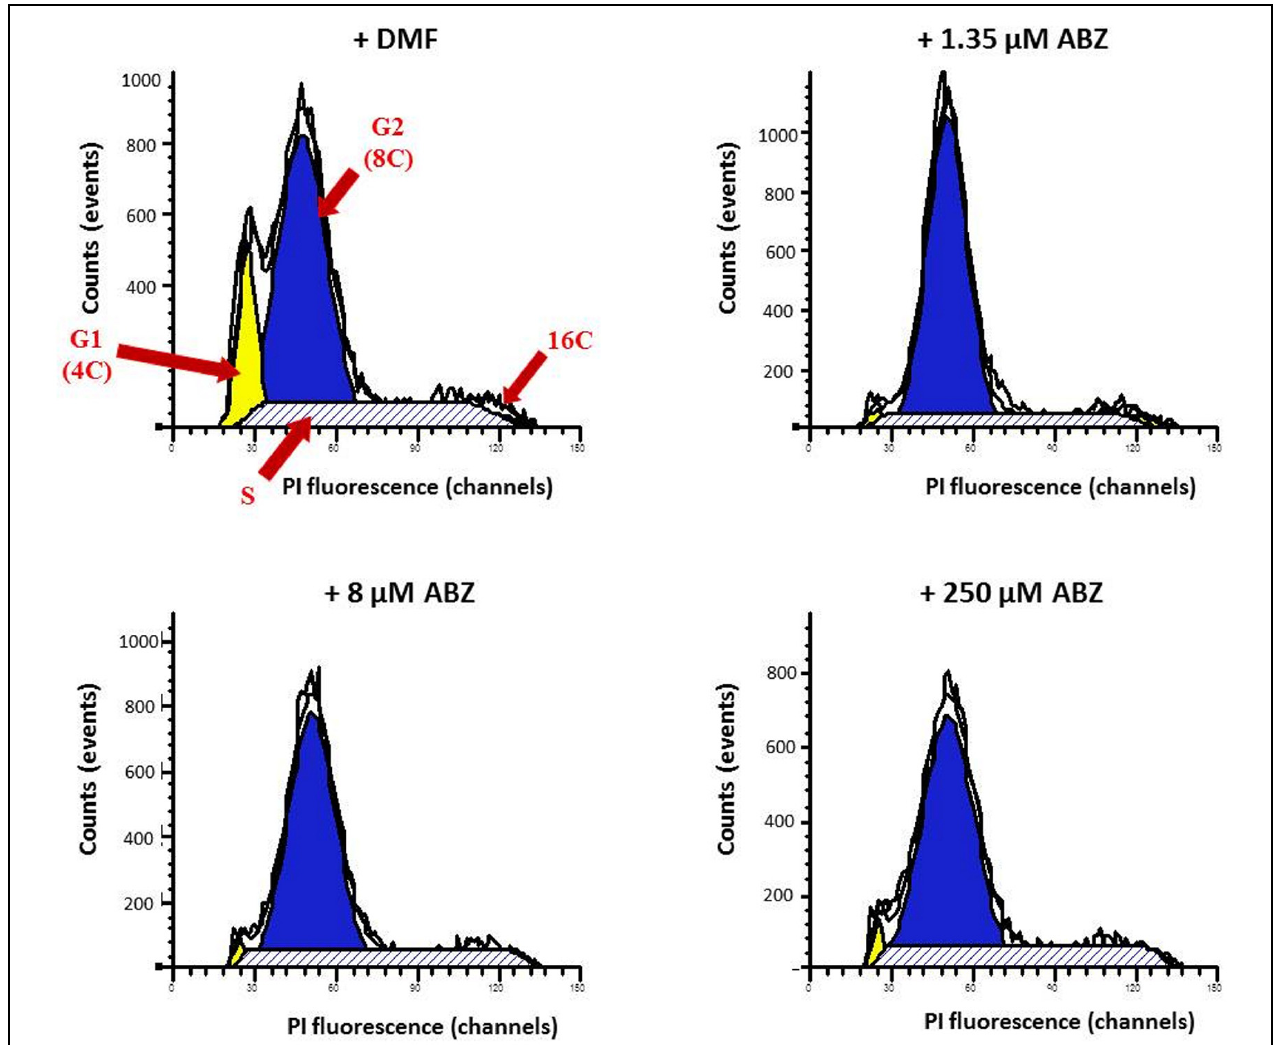
FIGURE 8 | Cell cycle stages determined by flow cytometry analysis in G. duodenalis trophozoites exposed to ABZ. Parasites were exposed to DMF (control) and to different ABZ concentrations (1.35, 8, and 250 μ M) for 4 h at 37 ◦ C. Then cells were stained with propidium iodide (PI) and PI fluorescence